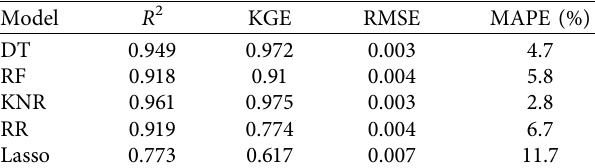
Table 4: Te calculated performance metrics for the oil shape factor over the testing